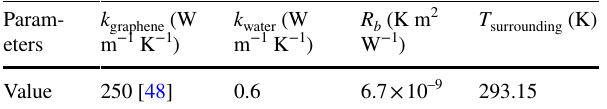
Table 1 LJ parameters and partial charges for graphene, water mol- ecules and functional groups Parameters Graphene